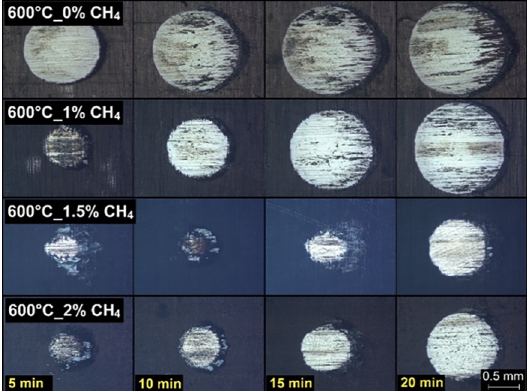
Figure 7. Wear craters for the samples nitrocarburized at 600°C.